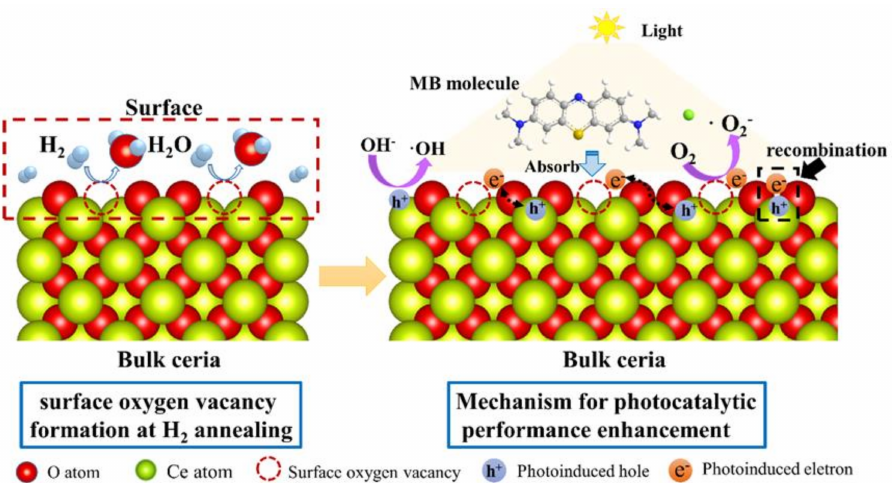
Figure 11. Mechanism schematic of promoted photocatalytic activity of surface contained